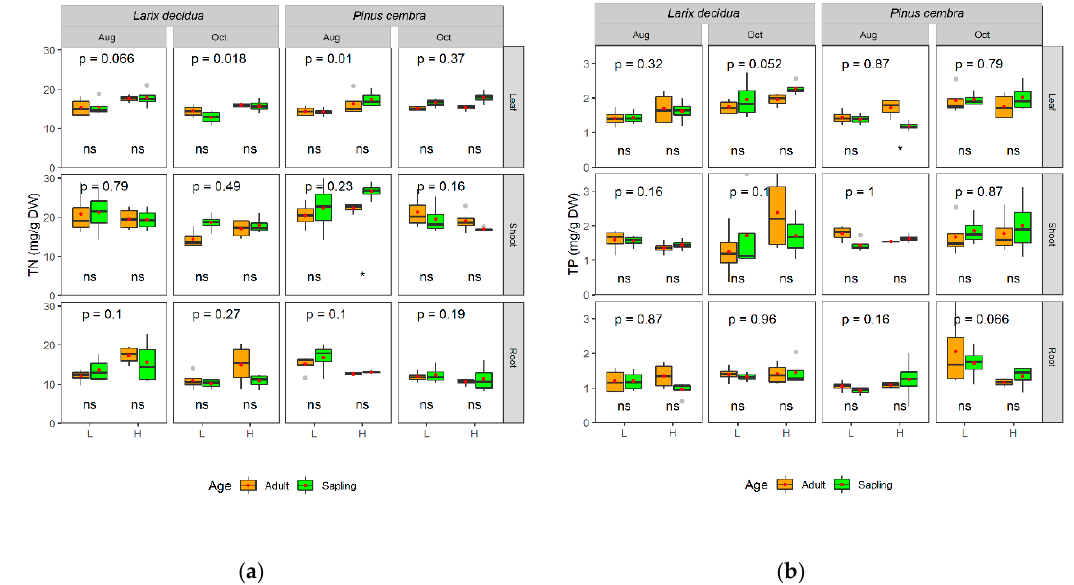
Figure 3. Total nitrogen (TN) ( a ) and phosphorus (TP) ( b ) concentrations (mg/g DW) (mean ± SE, n = 4) of different species ( Pinus cembra L. and Larix decidua Mill.), age (sapling and adult trees), altitude (L for timberline and H for treeline), season (August for mid-growing season and October for late season), and tissues (current-year leaf, shoot, and fine root). Asterisks or “ns” at the bottom of subplot indicate significant ( p < 0.05) or non-significant ( p > 0.05) differences between saplings and adults within the same altitude and season, and the p -value at the top of subplot denote significance level by the Wilcoxon’s mean test between L and H.